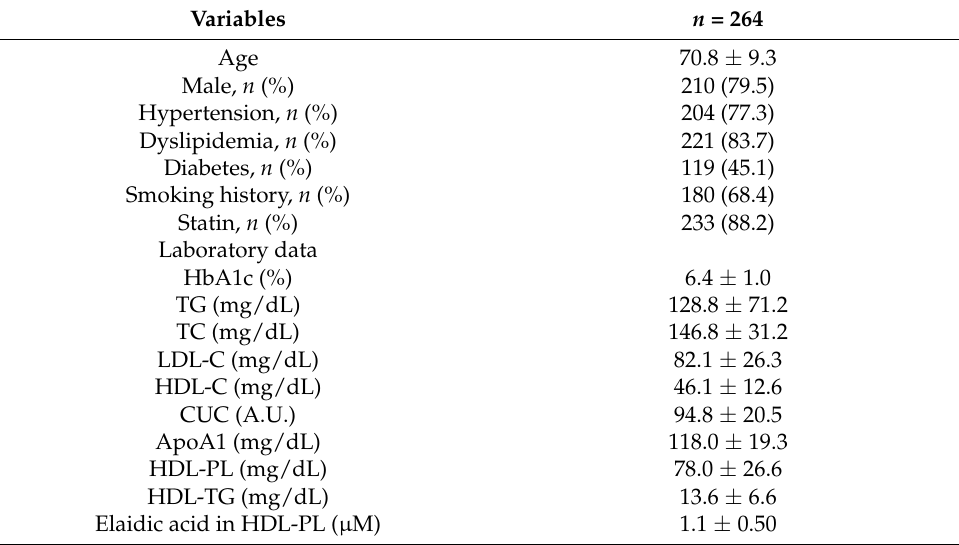
Table 1. Baseline patient characteristics and laboratory